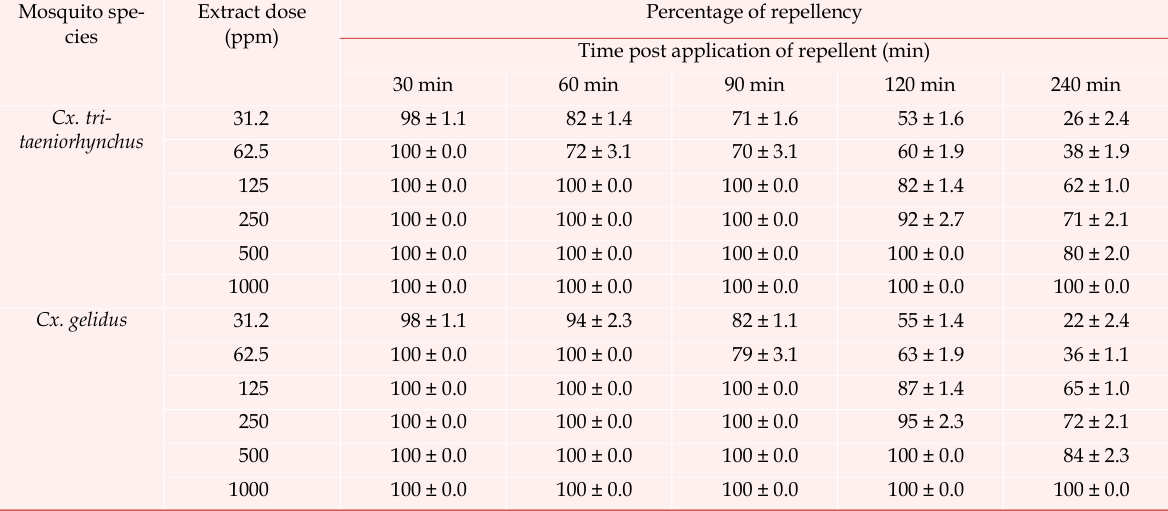
Dose dependent mosquito repellent activity of aqueous extract of Calotropis procera leaves against Cx. tri- taeniorhynchus and Cx. gelidus Mosquito spe-